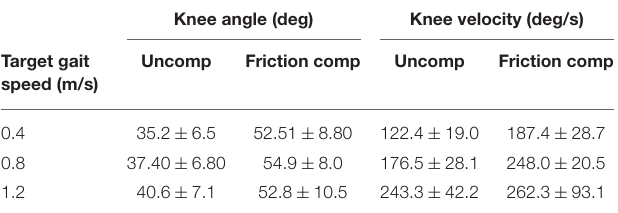
TABLE 4 | Average peak knee angles and velocities attained by subjects per condition over each gait